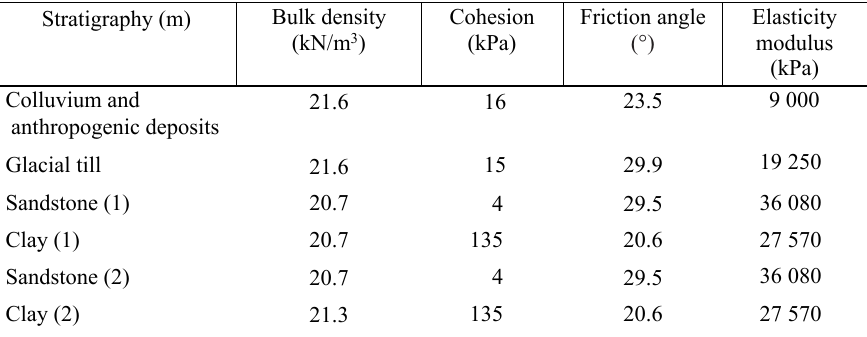
Table 1. Geomechanical properties applied in